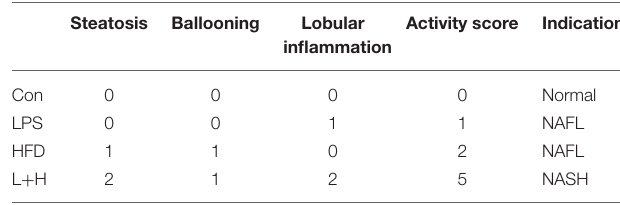
TABLE 1 | Quantify the histological changes in liver according to the Kleiner scoring system.